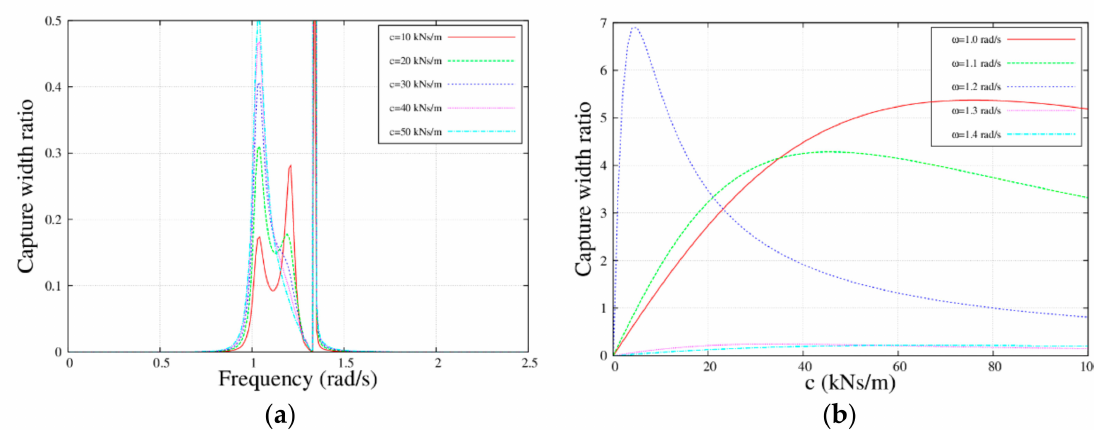
Figure 11. Capture width ratio with the PTO damping coe ffi cient and frequency for the MP–WEB, c = 10, 20, 30, 40, and 50 ( KNs/m ) ; ω = 1.0, 1.1, 1.2, 1.3, and 1.4 ( rad/s ) ( a ) Capture width ratio in di ff erent PTO damping coe ffi cient; and ( b ) capture width ratio in di ff erent